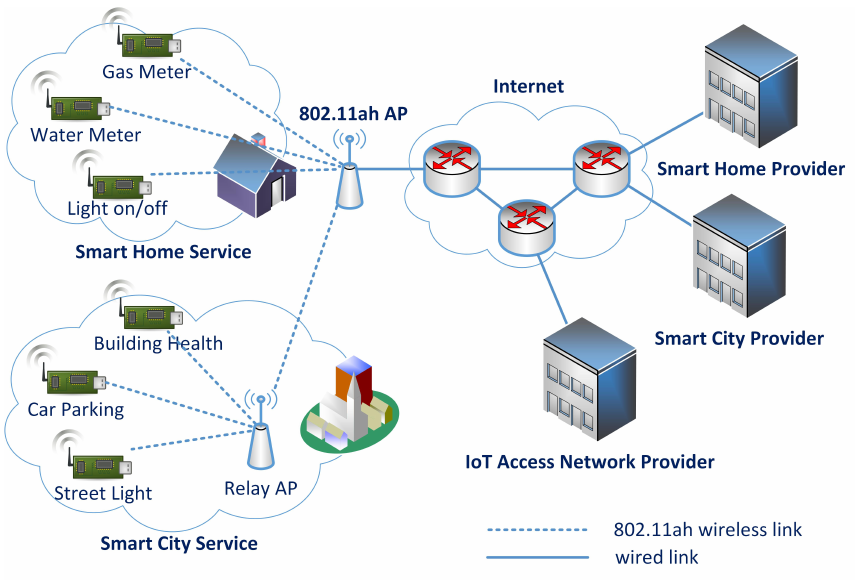
Figure 1. IEEE 802.11ah Network